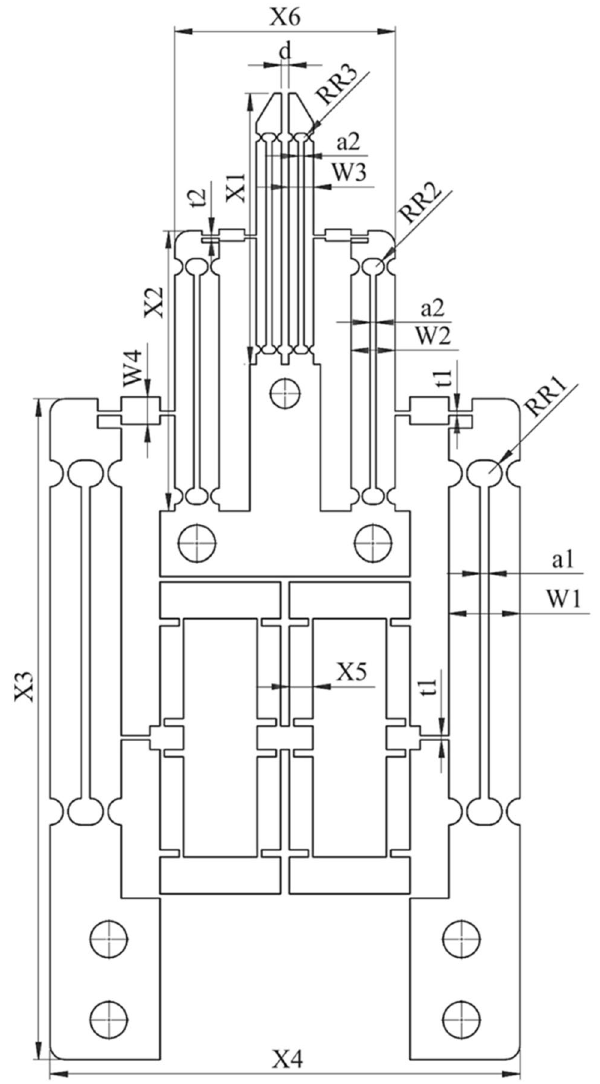
Fig. 2 Main design parameters of the proposed microgripper